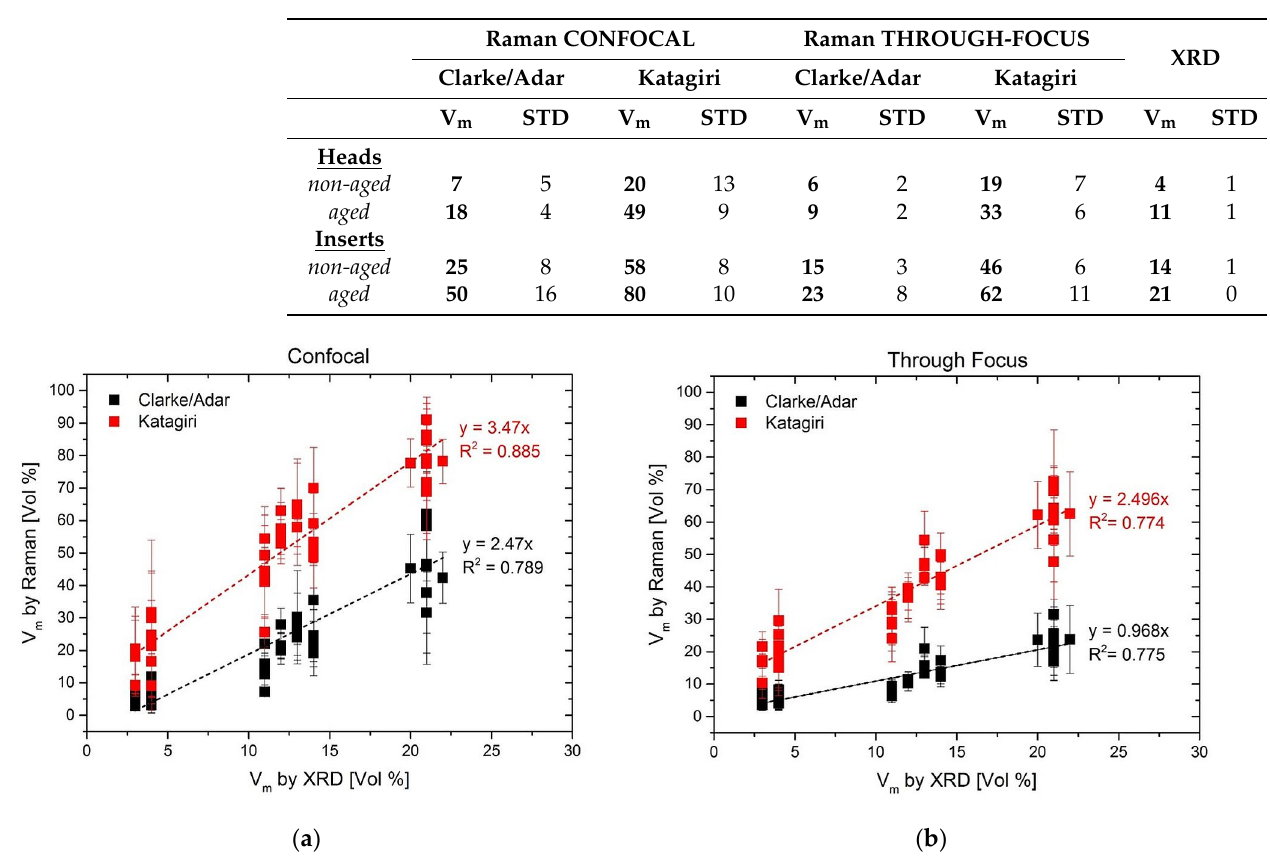
Figure 3. Comparison between all V m values measured by XRD and Raman spectroscopy and on both non-aged and in vitro aged Delta heads and inserts. ( a ) Confocal = confocal pinhole closed down to 100 µ m (penetration depth of Raman signal: 4.2 µ m); ( b ) Through Focus = confocal pinhole fully open (1000 µ m)—penetration depth of Raman signal: 15 µ m. The Through Focus measurement mode (with the Clarke/Adar equation) best reproduces the XRD results due to the similar probed volume (penetration depth of XRD: 17 µ